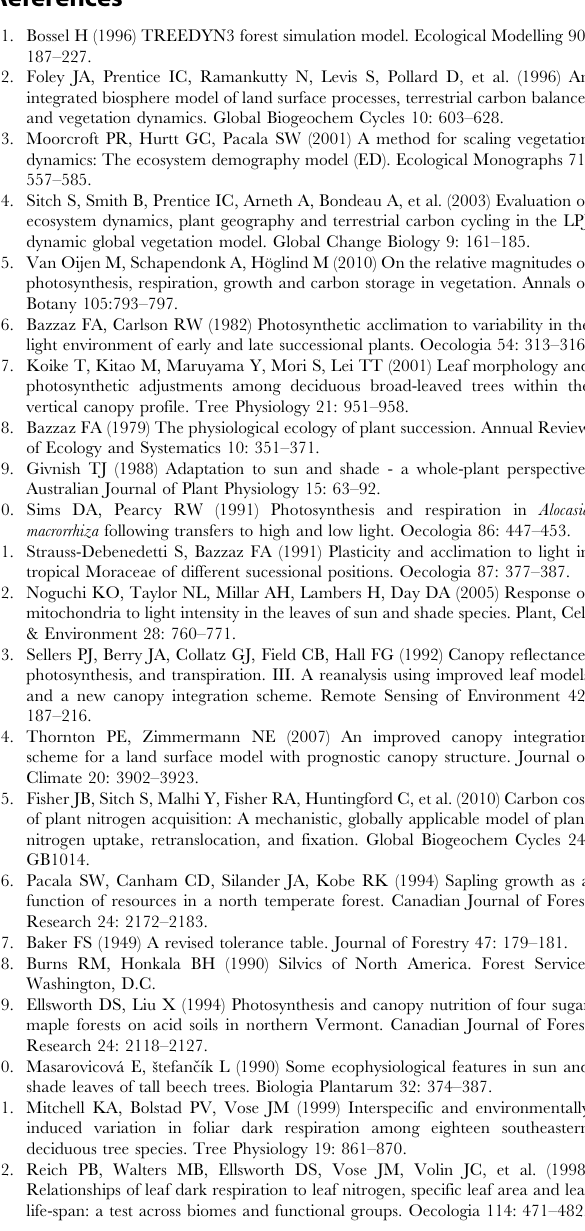
Table S1 Sample sizes of different species and mea- surements. * shade leaves of sun grown trees, for which light data are not available; { no light data is available for all American beech samplings. Table S2 Comparison of models of leaf maximum net photosynthetic capacity (Amax) and dark respiration rate (Rdark) in response to light level. Note this table is the same as Table 1, except that the analysis presented in this table does not include data of gray birch. The symbol ‘-’ indicates that the model does not return a valid estimate of parameter m i (the mean Amax or Rdark of a species-i leaf in full sun), which needs to be positive by definition. See the description in Table 1 for more